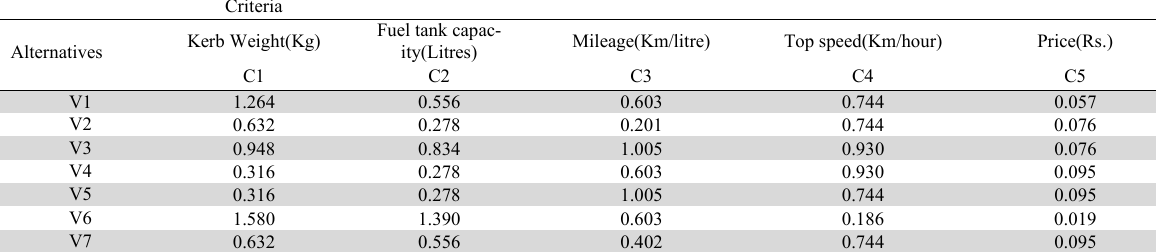
Weighted normalized decision matrix